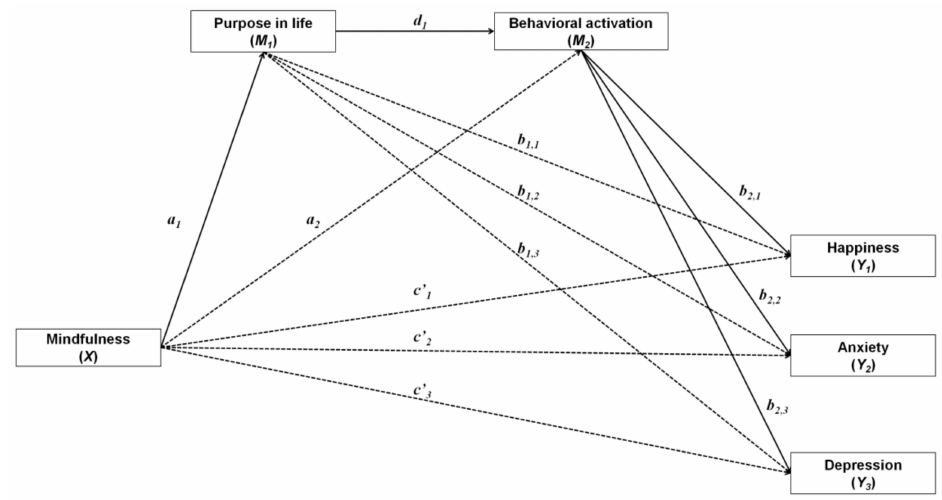
Figure 1. Hypothesized multiple-step multiple mediator model.